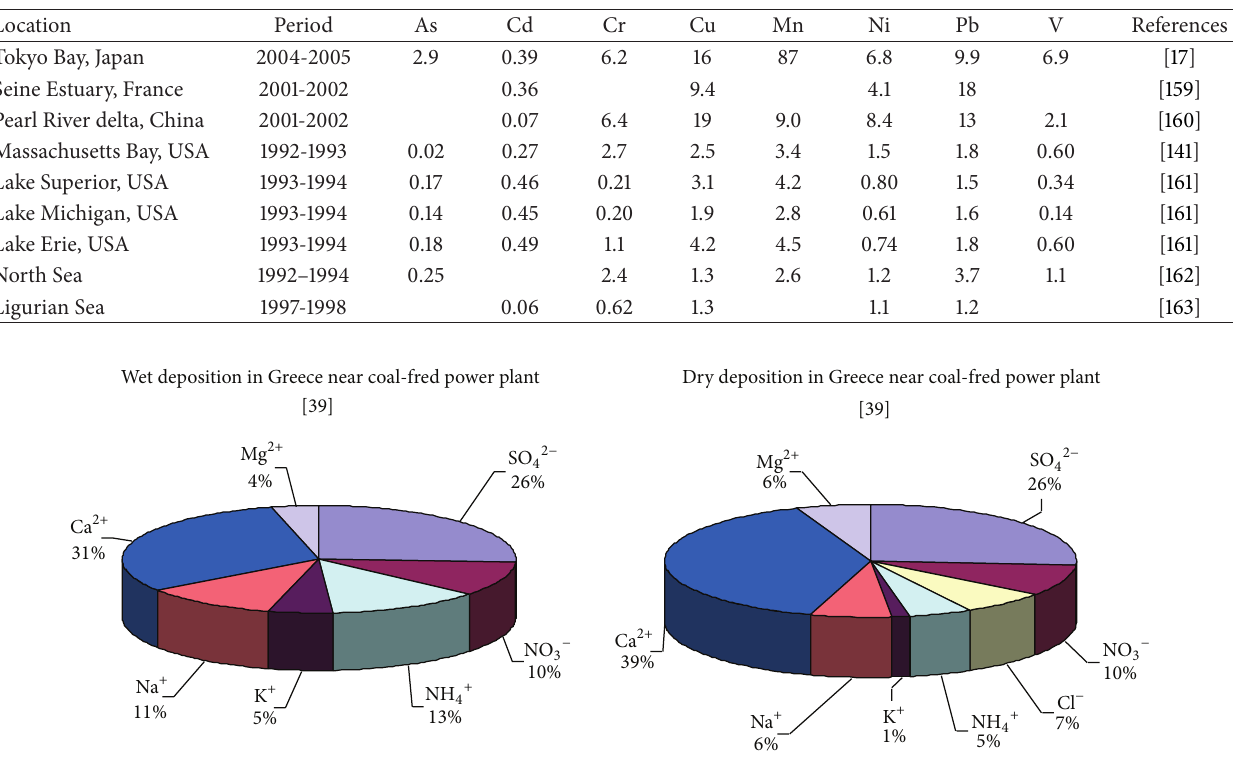
Figure 3: Wet and dry deposition fluxes percentage of ions at a site downwind to coal-fired power plants in Northwestern Greece